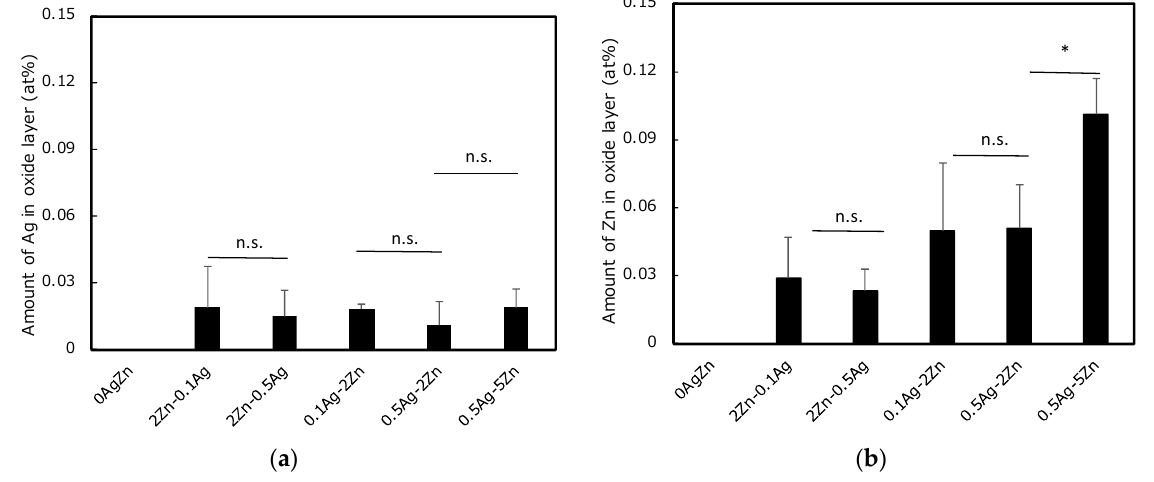
Figure 7. Amounts of ( a ) Ag and ( b ) Zn in the oxide layer after two months of aging measured via EDS (* statistically significant difference, p < 0.05; n.s.: no significant difference). Measurements were performed on three equally conditioned specimens ( n = 3).